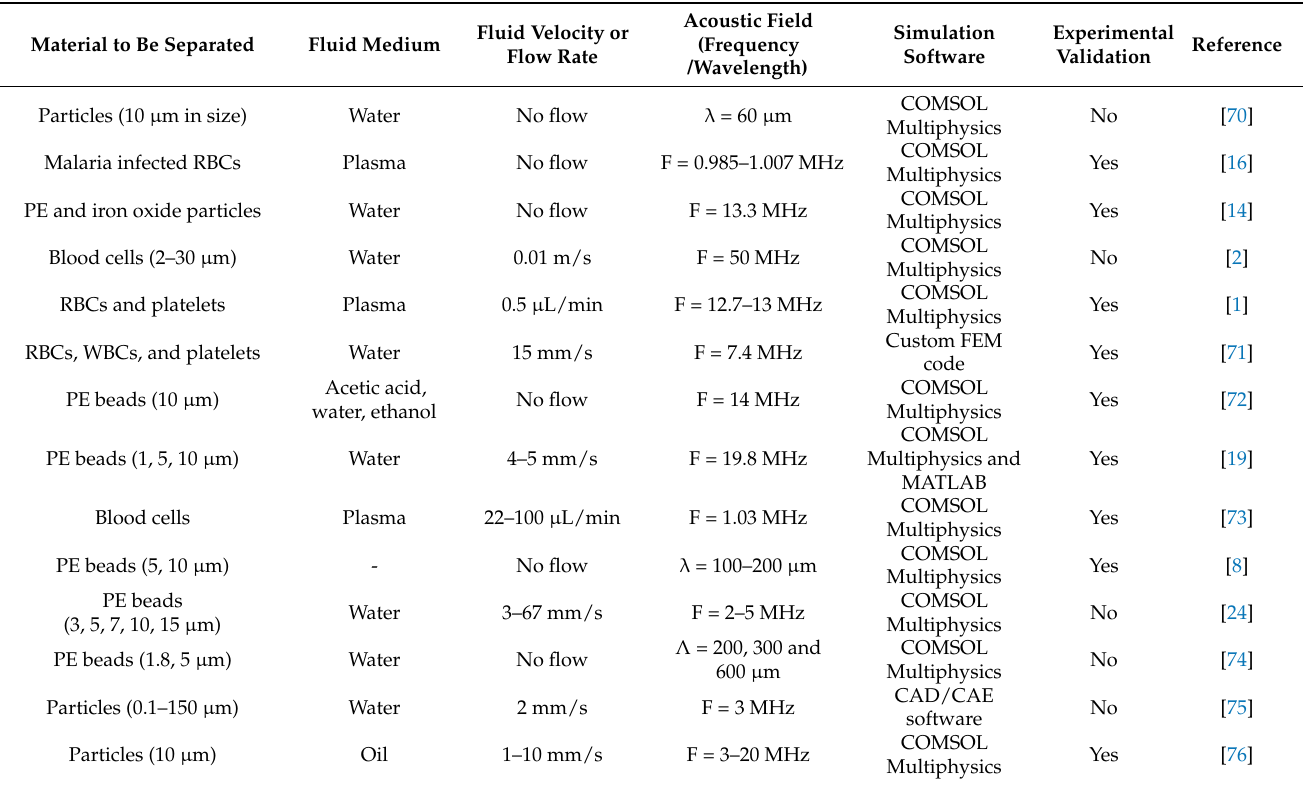
Table 3. Simulation studies dealing with particle and cell acoustophoresis in